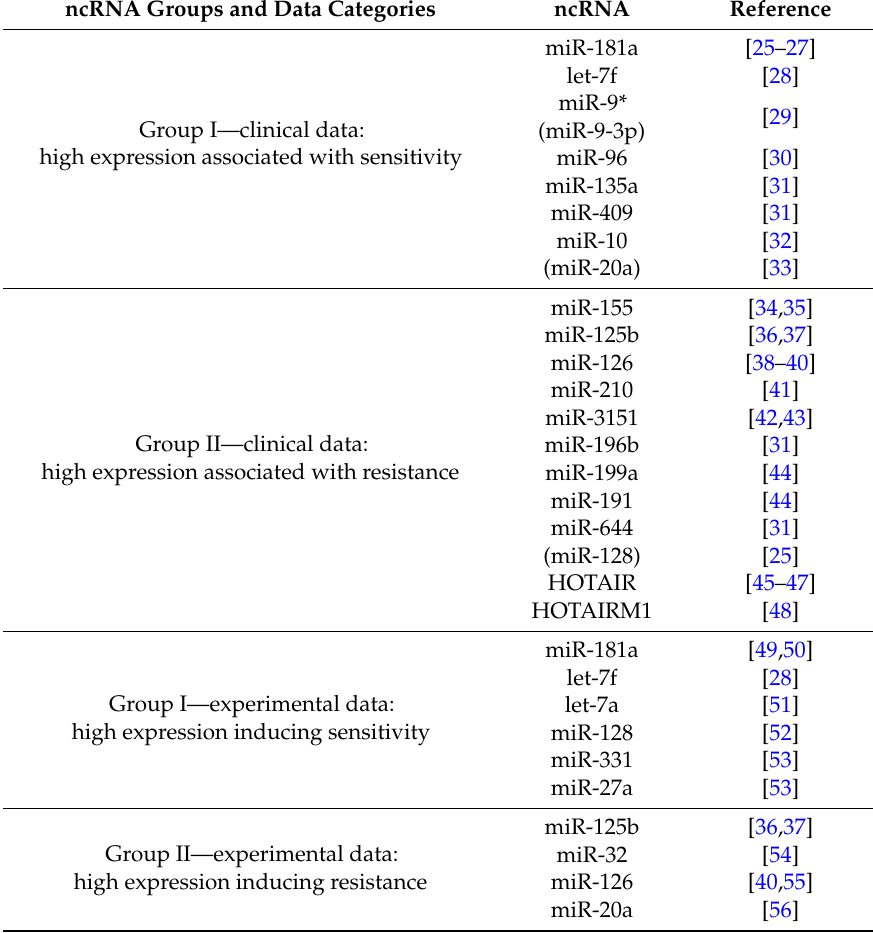
Table 1. Non-coding RNAs (ncRNAs) linked to therapeutic resistance and sensitivity, respectively, to high intensity treatment regimens in acute myeloid leukemia